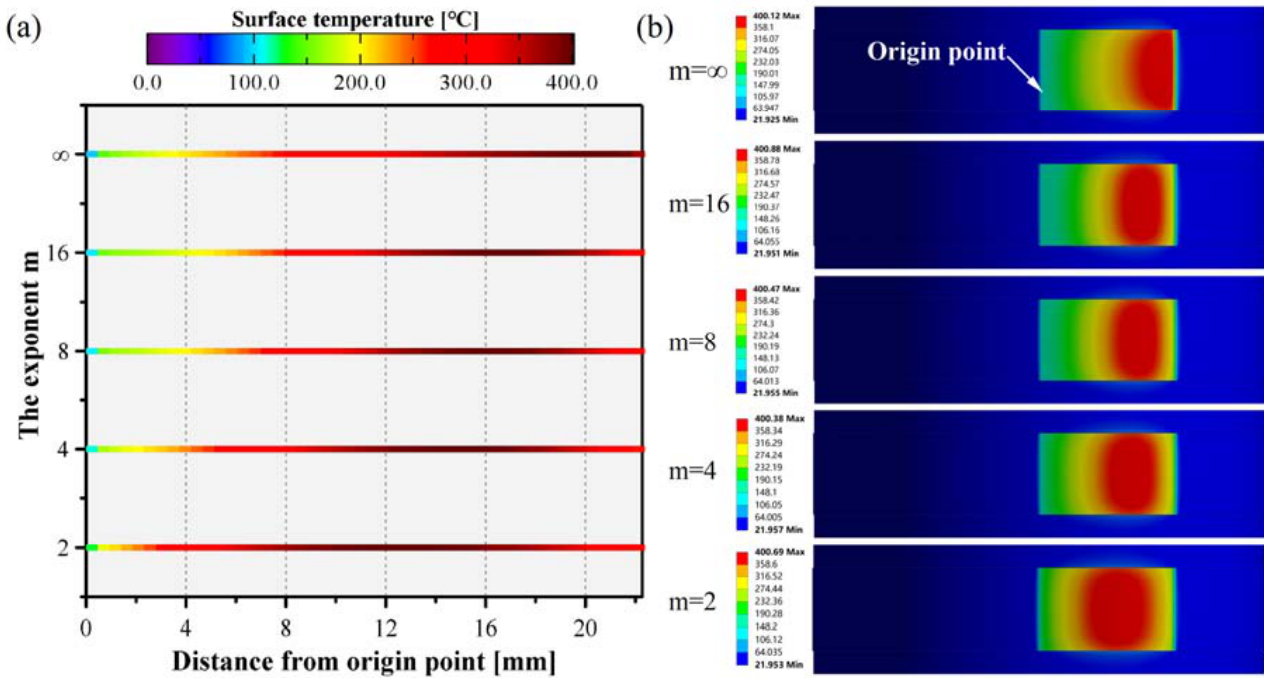
Figure 14. The center temperature in width direction ( a ) and surface temperature distribution ( b ) of Figure 14. The surface temperature distribution of the curved tape was obtained by the thermal the curved tape was obtained by the thermal simulation simulation model.